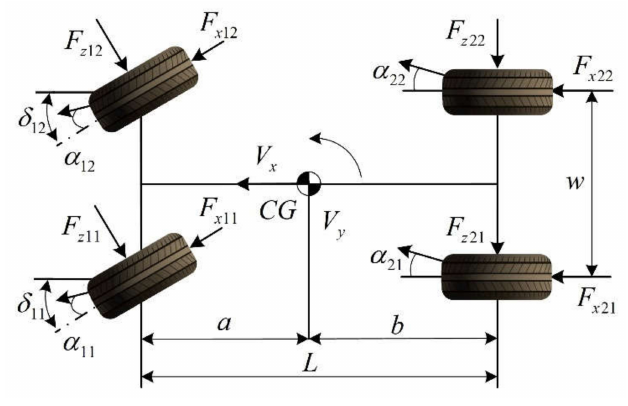
Figure 1. Planar vehicle